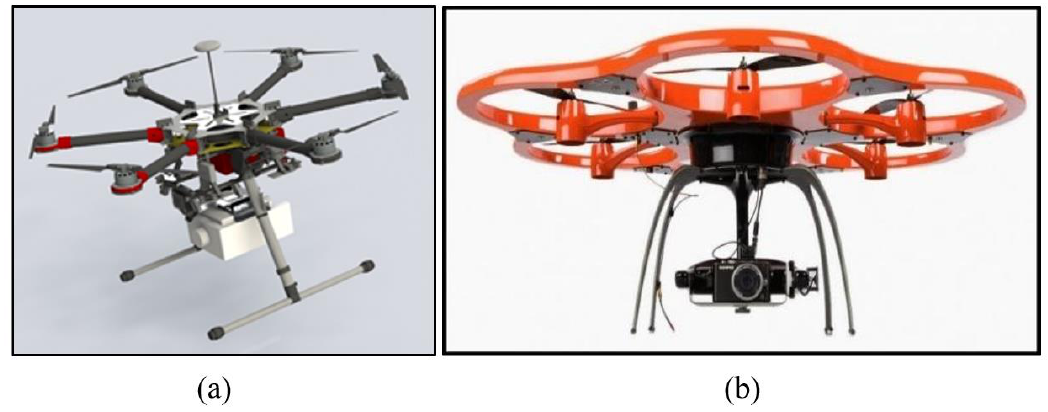
Figure 1. SR-FG6 hexacopter model ( a ) and a joint ducted propellers hexacopter ( b ).